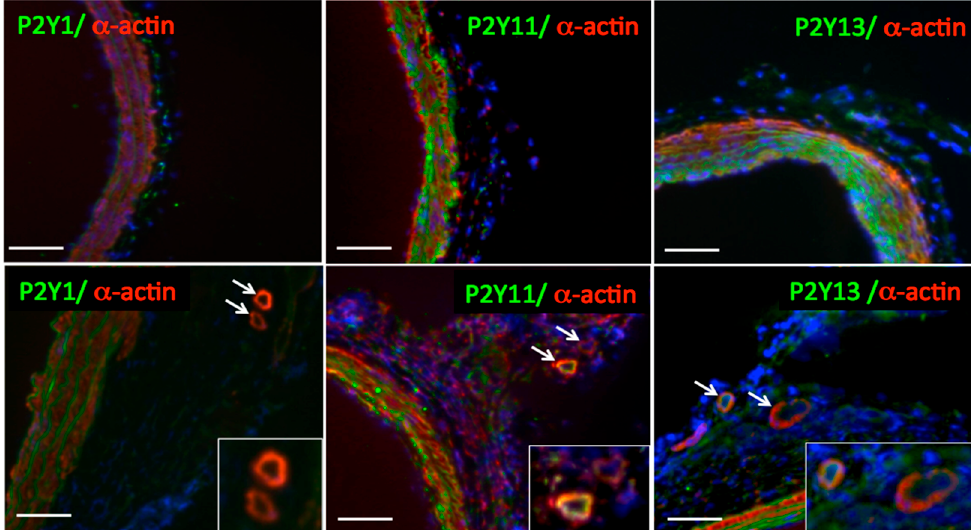
Figure 4. P2Y1, P2Y11, and P2Y13 purinergic receptors are expressed in angiogenic pulmonary artery vasa vasorum . Immunofluorescent analysis of frozen acetone/methanol-fixed tissue sections of control and chronically hypoxic rats (4 weeks, (barometric pressure) P B 430 mmHg) revealed pulmonary artery adventitial vasa vasorum expansion (white arrows) and the expression of P2Y1, P2Y11, and P2Y13 receptors (green), and α -actin (red) in chronically hypoxic, but not control animals; scale bar = 100 µm.